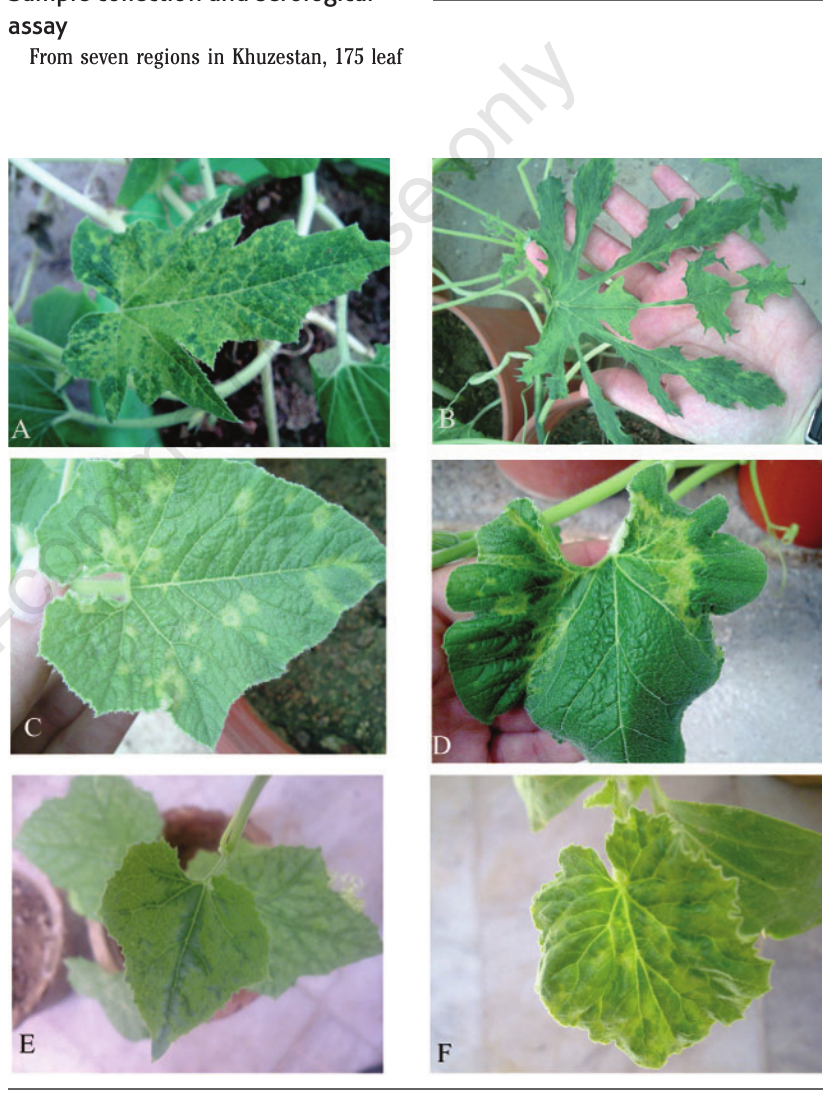
Figure 2. Symptoms of Khuzestan isolates. Mosaic & leaf deformation in Cucurbita pepo cv. White Bush by Dezful isolate (A). Leaf deformation & shoe stringing caused by Shushtar isolate (B). Ring spot in Cucurbita pepo cv. Sefide Gavi caused by Hamidieh iso- late (C). Rugose & mosaic caused in Cucurbita pepo cv. Sefide Gavi by Molasani isolate (D). Green veining banding in Luffa acutangula , 2 week after inoculation (E). Blistering & mosaic in Cucumis melo cv. Abas Shori